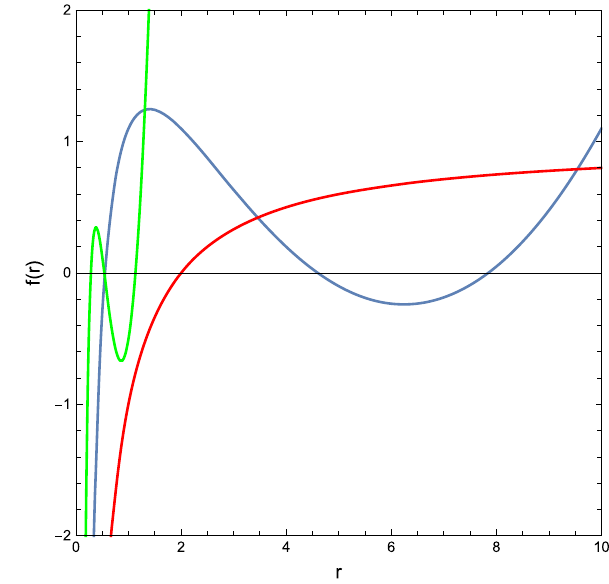
Fig. 1 The graph illustrates the profile of f ( r ) . The green and blue curves show three event horizons of the black hole in dRGT massive gravity. Also, the red curve is related to the Schwarzschild black